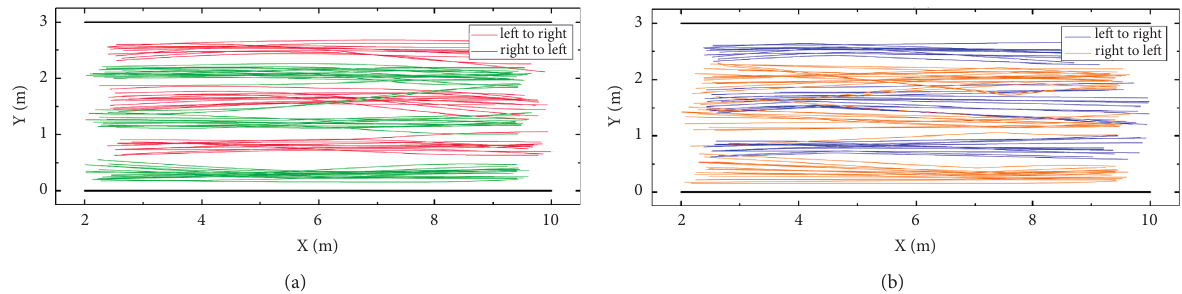
Figure 14: Comparison of predicted and real pedestrian trajectories in the bidirectional flow scenario, in which pedestrian positions of the first five time steps are used as historical movement for the reference of initial simulation. (a) Pedestrian trajectories in the experiment. (b) Pedestrian trajectories in the simulation.